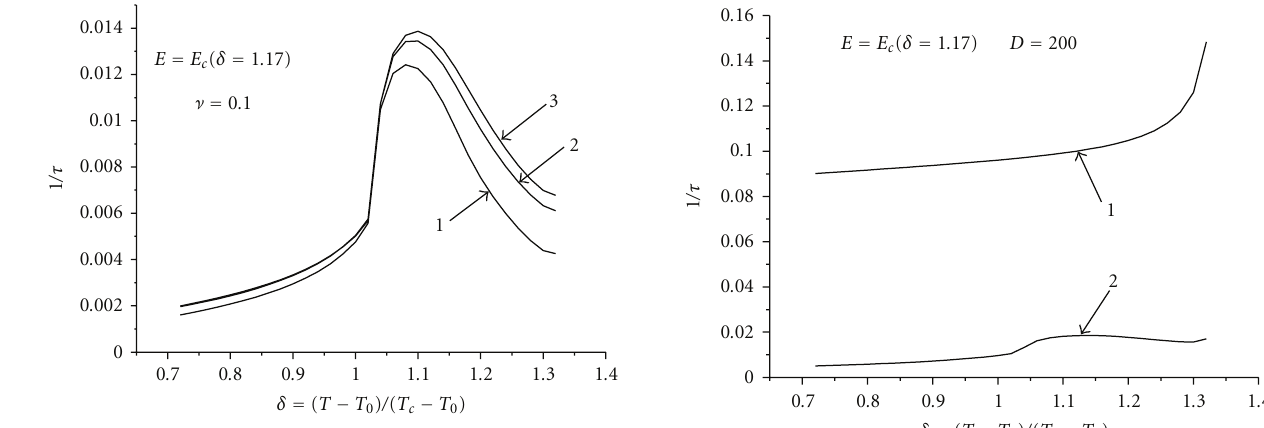
Figure 6: Dependence of the switching rate, 1/ τ (in units of β 2 /γη ), from the first stable ferroelectric state to the second one (or from the first metastable state to the second one) for the 2D system undergoing a first-order phase transition at E = E c ( δ = 1 . 17) on the dimensionless temperature δ . The number of dipoles N = 64 × 64, ν = 0 . 1 and D = 0 . 05 (curve 1), D = 0 . 5 (curve 2), D = 5 (curve 3). The initial conditions describe the nucleus of the ferroelectric state inside the domain with polarization of the opposite direction. One can see that the behavior of the dependence is nonmonotonical.